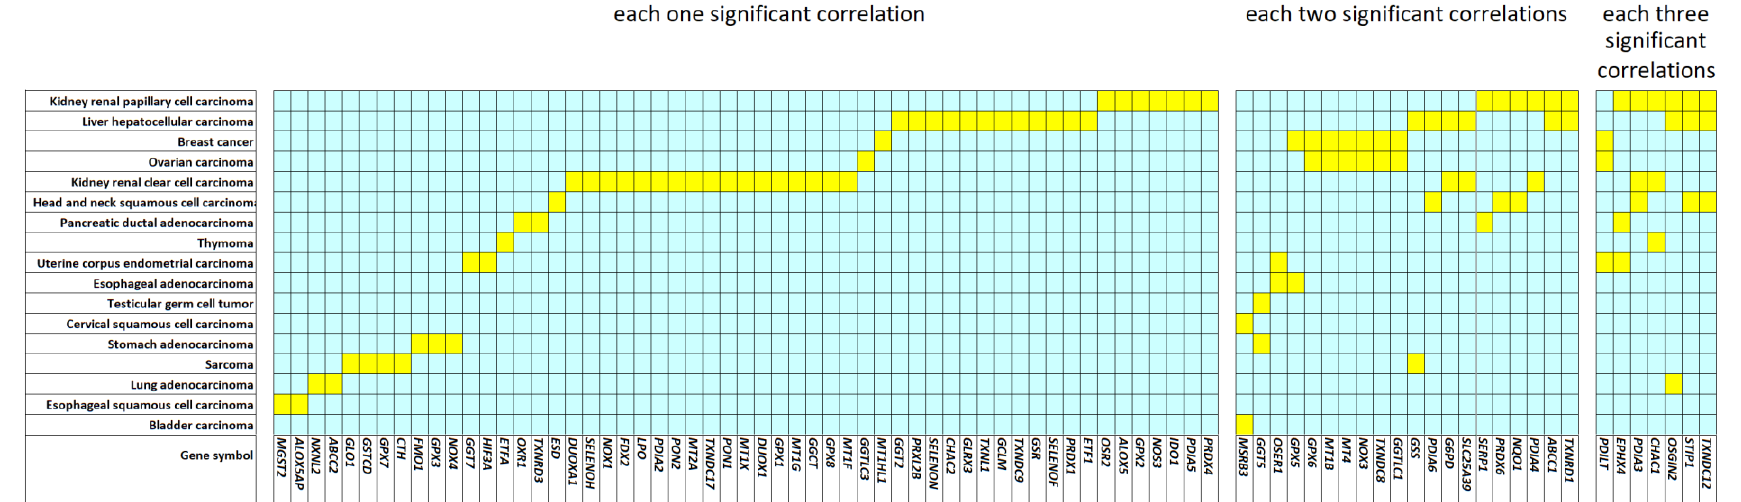
Figure 2. Color-coded plot of Kaplan–Meier statistics of 84 genes for 17 tumor types. Yellow indicates significant correlations between high gene expression in tumors and worse overall survival of patients. Blue indicates irrelevant outcomes.